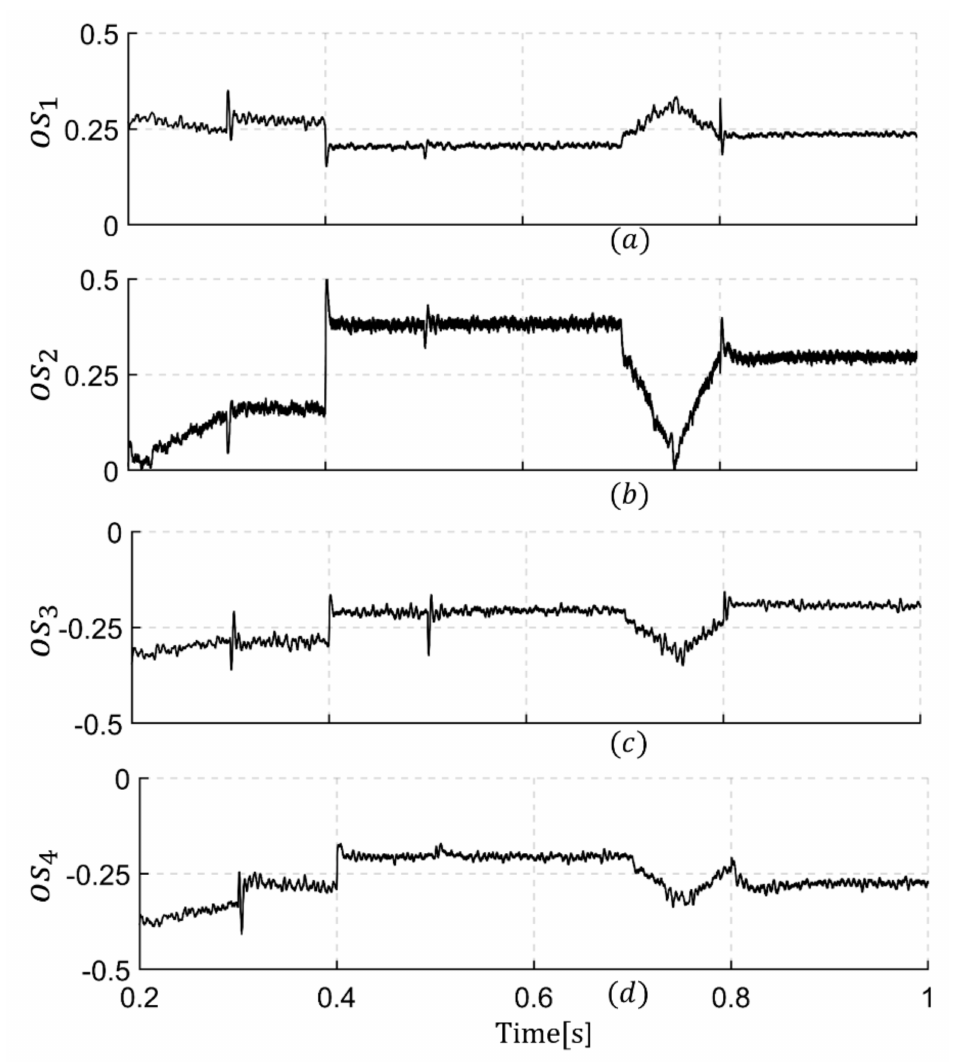
Figure 12. The needed offsets to be added to the reference voltages ( a ) offset for RES1 side converter, ( b ) offset for RES2 side converter, ( c ) offset for grid side converter and ( d ) offset for the drive side